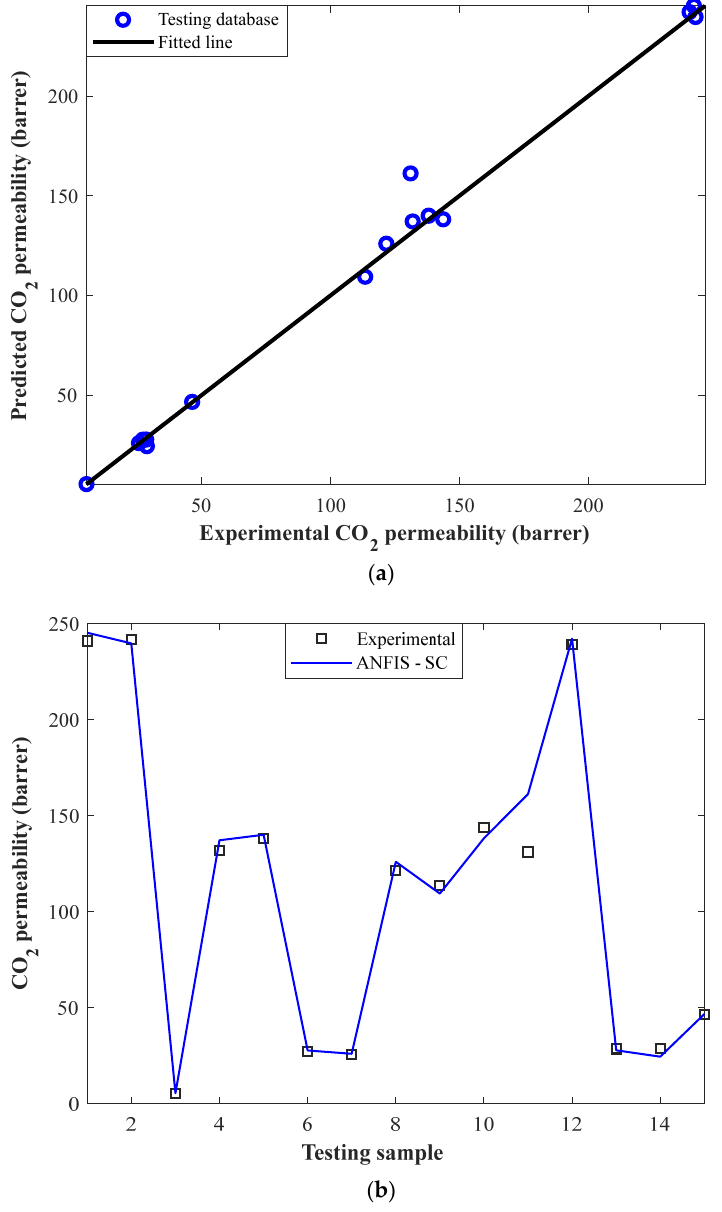
Figure 4. ( a ) Cross-plot of ANFIS-SC predictions versus experimental CO 2 permeabilities in the testing step. ( b ) Experimental CO 2 permeabilities and their related ANFIS–SC predictions in the testing step.